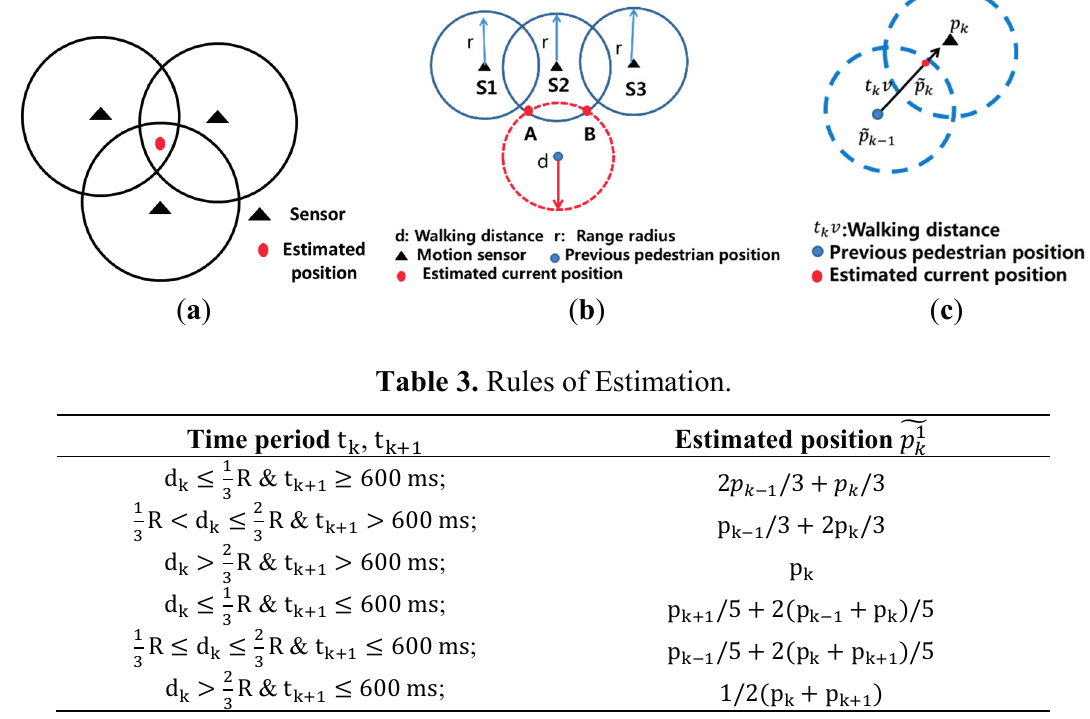
Figure 6. Schematics of ( a ) proximate method; ( b ) circ-circ method; ( c ) Kalman filter approach.